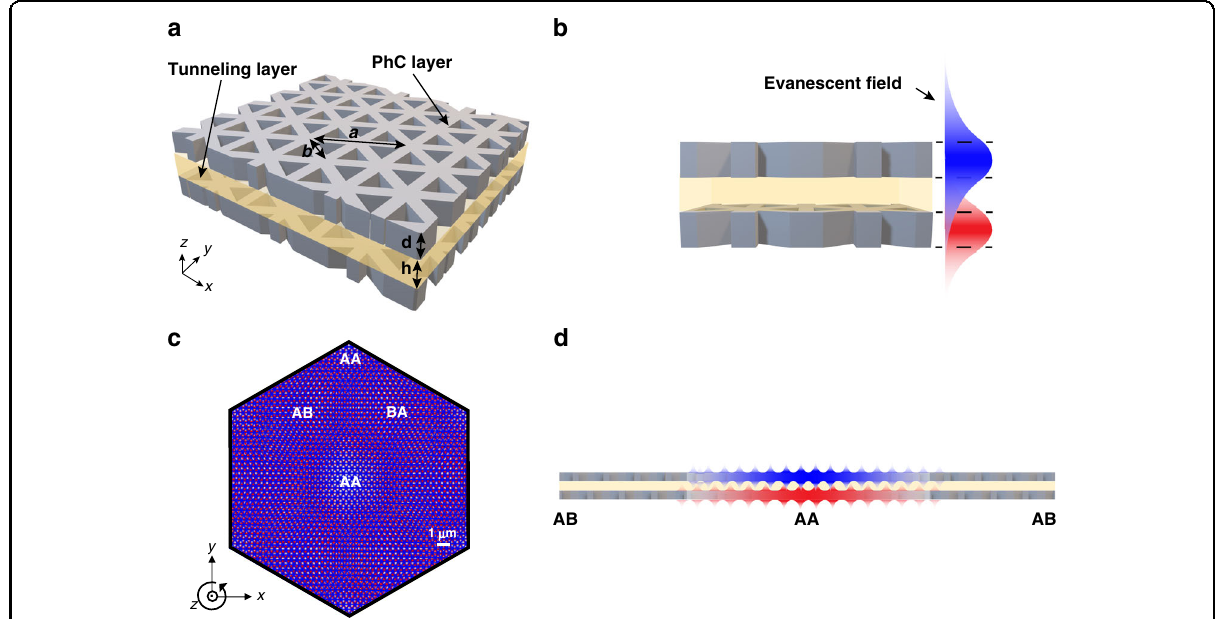
Fig. 1 Twisted bilayer photonic crystals. a Bilayer photonic crystal (BPhC) consisting of a tunneling layer with a low refractive index sandwiched between two twisted dielectric layers. The 2D photonic crystal is a d = 220-nm-thick crystalline silicon membrane ( n Si ¼ 3 : 48) with C 6 v symmetry- protected triangular shape air holes. The triangular holes have a side length of b ¼ 279nm and the unit cell pitch is a ¼ 478nm. The interlayer tunneling membrane has a thickness of h ¼ 250nm and the refractive index of polymethyl methacrylate (PMMA) is n PMMA ¼ 1 : 48. b Two layers are separated by PMMA with only a subwavelength distance h , suggesting an evanescent coupling between two layers of photonic crystals. c Moiré pattern for a TBPhC, where the two dielectric layers are rotated by angle θ with respect to each other around the AA-stacked center. In a moiré pattern, lattice structure locally resembles the regular stacking arrangement such as AA, AB, and BA. d Evanescent waves from two layers of photonic crystals are mostly coupled in the AA-stacked